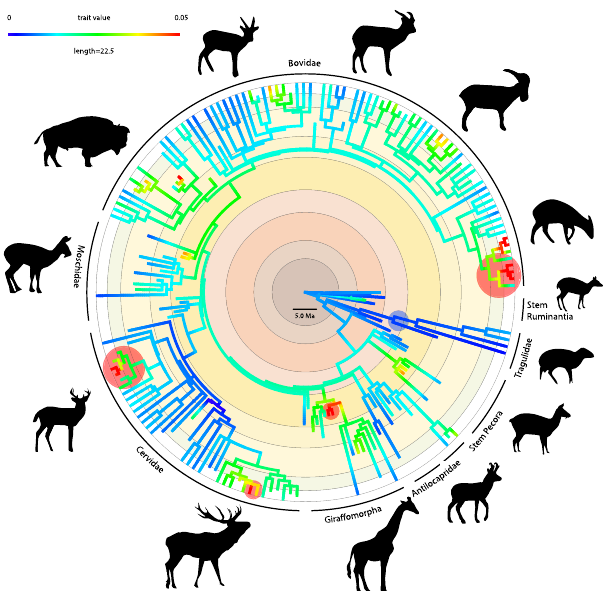
Fig. 2 | Evolutionary rates of the ruminant bony labyrinth morphology based on PC scores through the phylogenetic tree. Signi fi cant decrease in the evolu- tionary rates (blue circle) is observed within the tragulid evolution, while a sig- ni fi cantincreaseofthe evolutionaryrates(redcircle)isobserved atthe baseofthe Giraffomorpha during the Early Miocene and within the South American deer, insular cervini, and the duikers during the Pleistocene (Supplementary Data 1). Methodology and statistical results produced by the R packages RRphylo 91 and Phytools 88 are provided in Material and Methods and Supplementary Data 1.